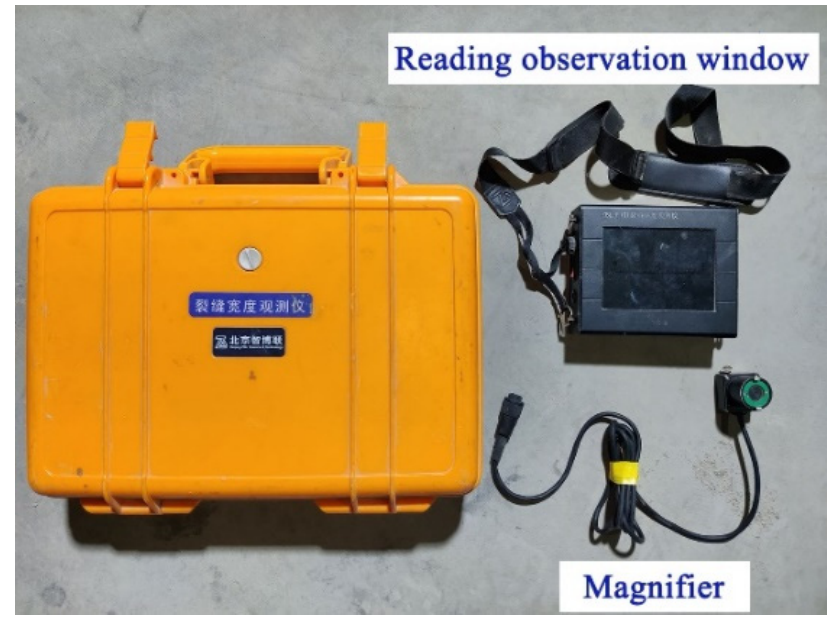
Figure 8. Crack observation instrument.